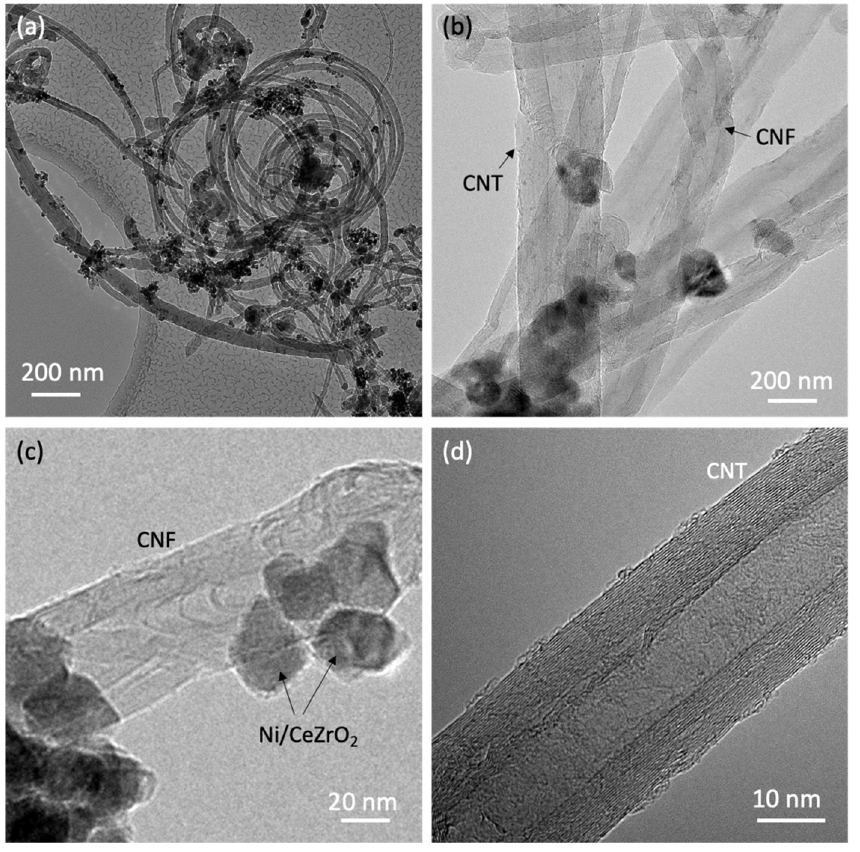
Figure 4. SEM images of the Ni/CeZrO 2 catalyst after toluene steam reforming carried out at S/C = 1.